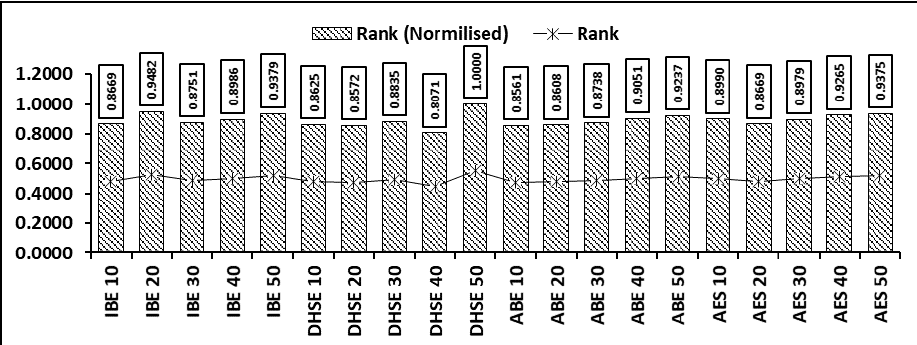
Figure 11. Relative importance of attributes of proposed approach.